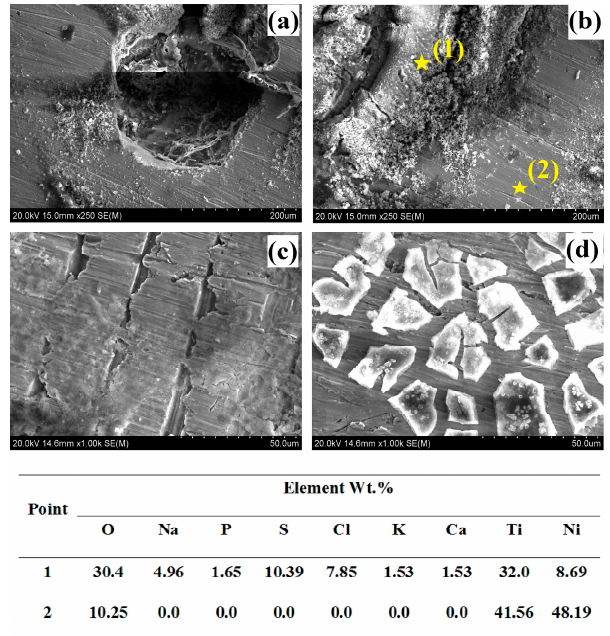
Figure 7. SEM investigation and EDS point spectrum analysis of the corroded surface after the potentiodynamic polarization test in SBF at 7.4 pH and 37 °C, ( a , b ) show the pits with corrosion product agglomerations at 250× magnification, ( c , d ) show the corroded surface at 1000× magnification.